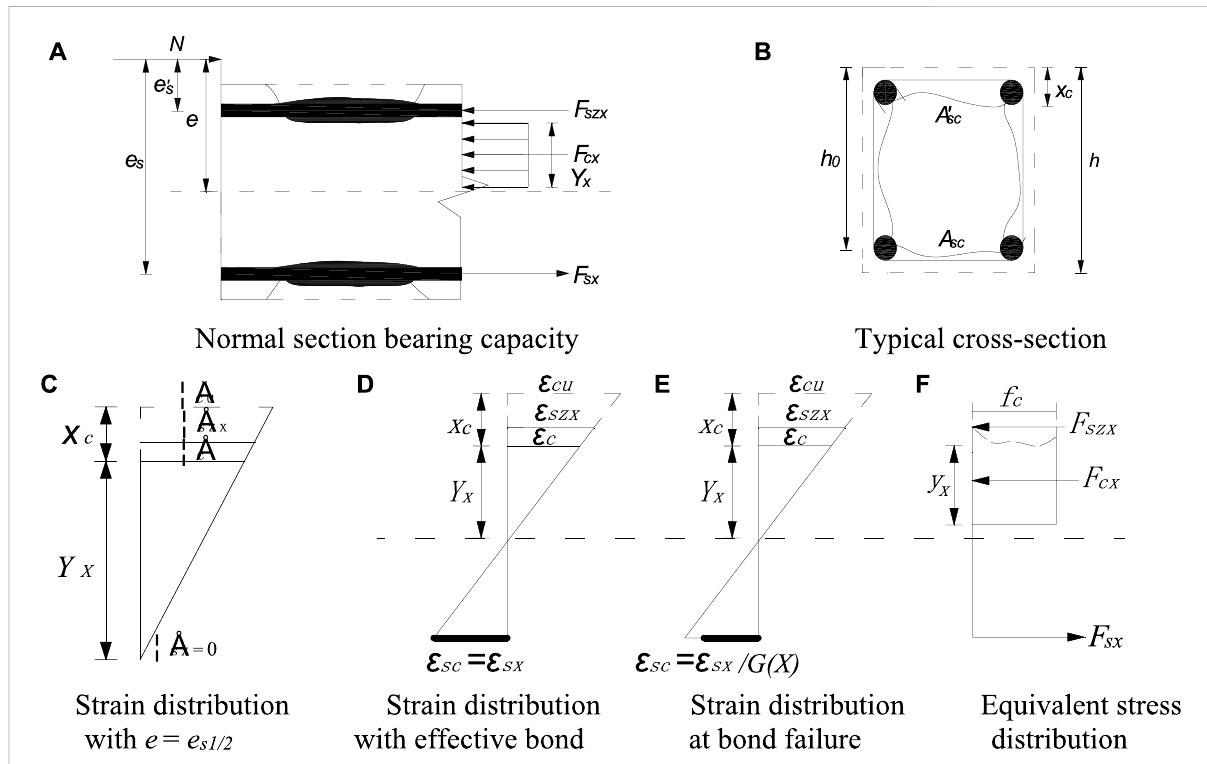
FIGURE 3 Applied forces and stress distribution diagram of the cross-section of the corroded RC column and its parameter de fi